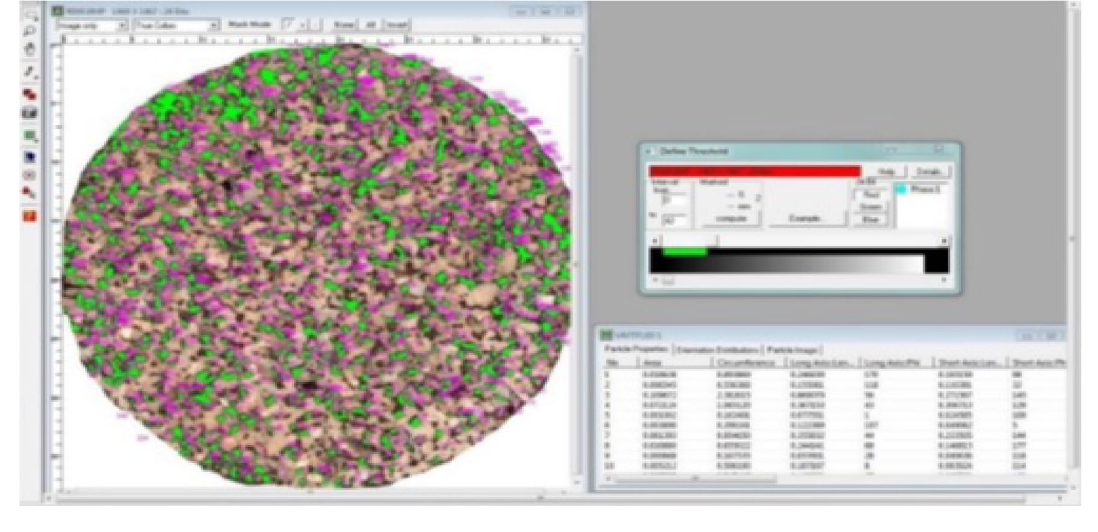
Fig. 3 Threshold definition (Zafari 2014) Fig. 4 Particle size distributions of carbonate chips (K1, K3, A1 and K4) determined from 2-D scanning (purple: surface area value; green: